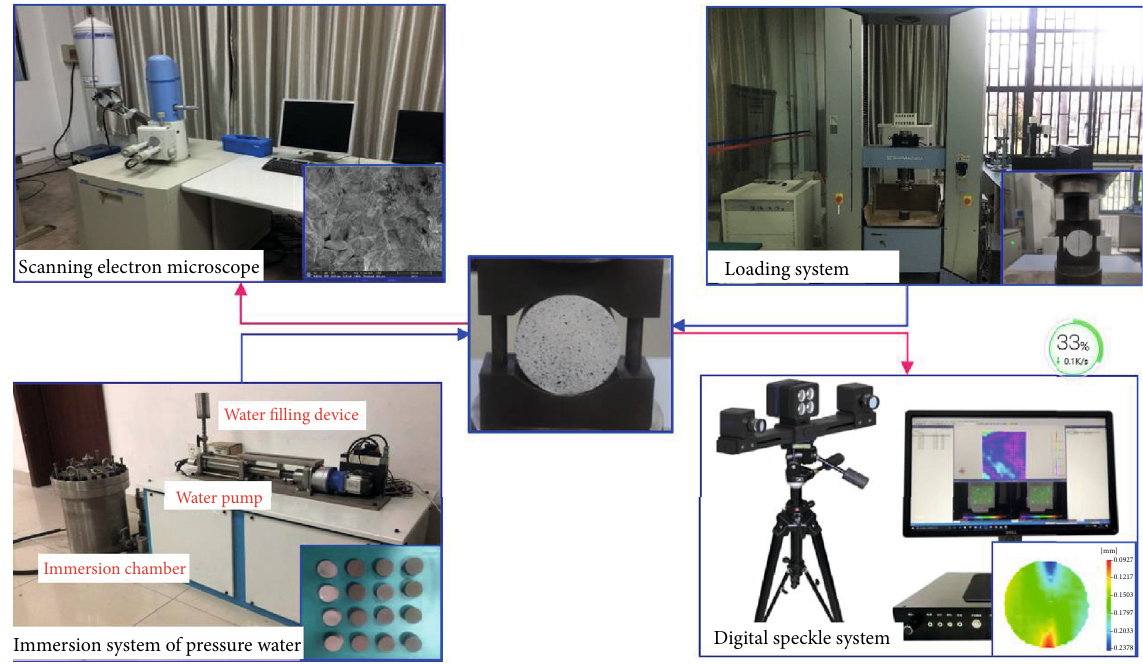
Figure 3: System for the Brazilian splitting testing of sandstone